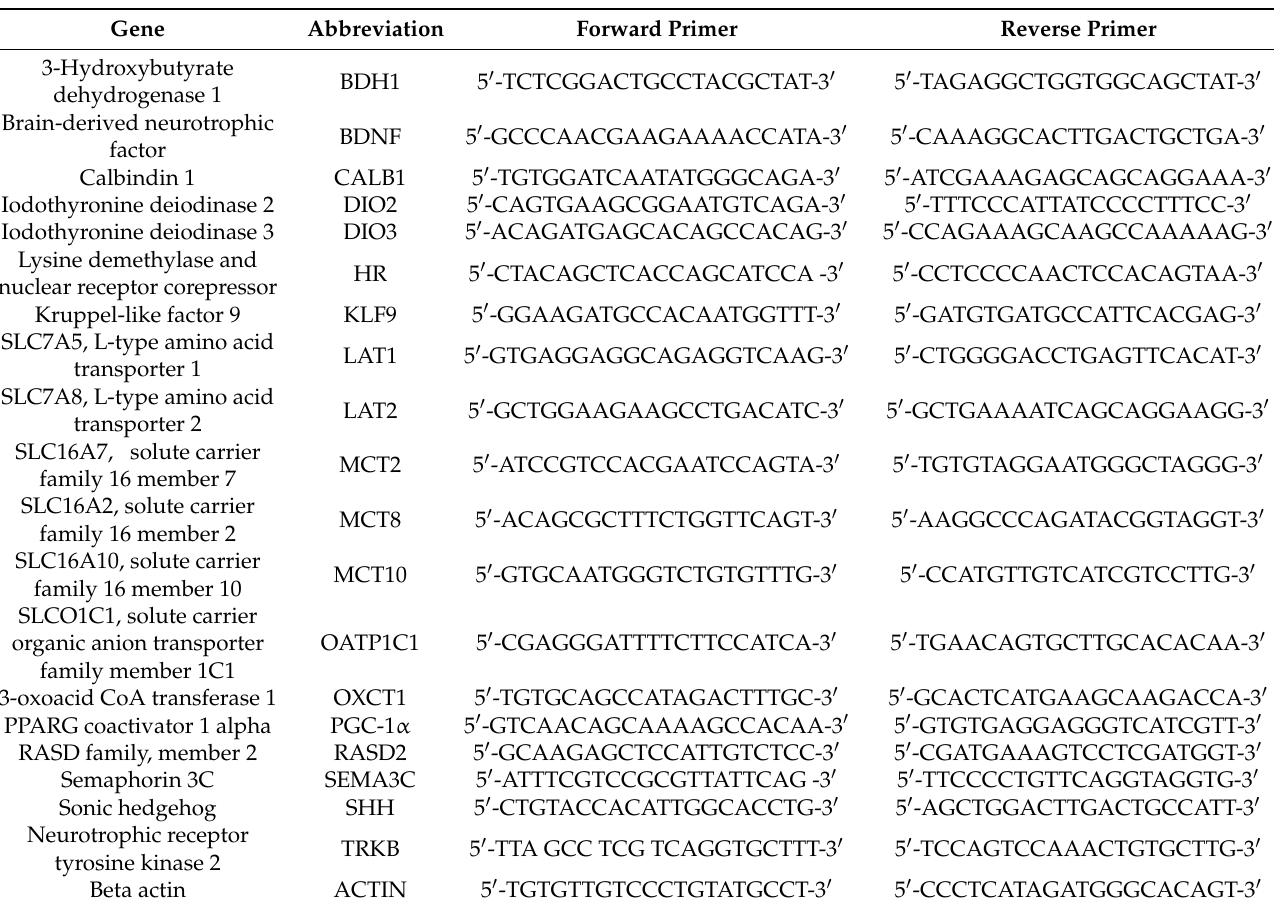
Table 2. List of primers used for Q-PCR in this